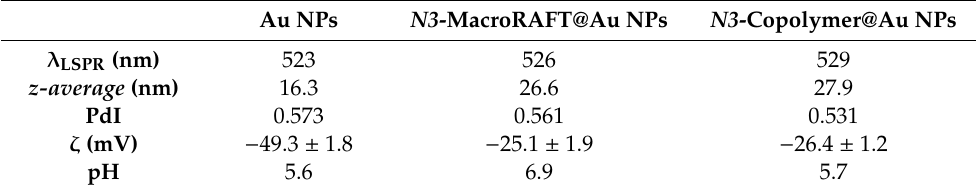
Figure 3. UV-Vis spectra of Au nanostructures before and after emulsion copolymerization at 44 °C, with azide moiety .